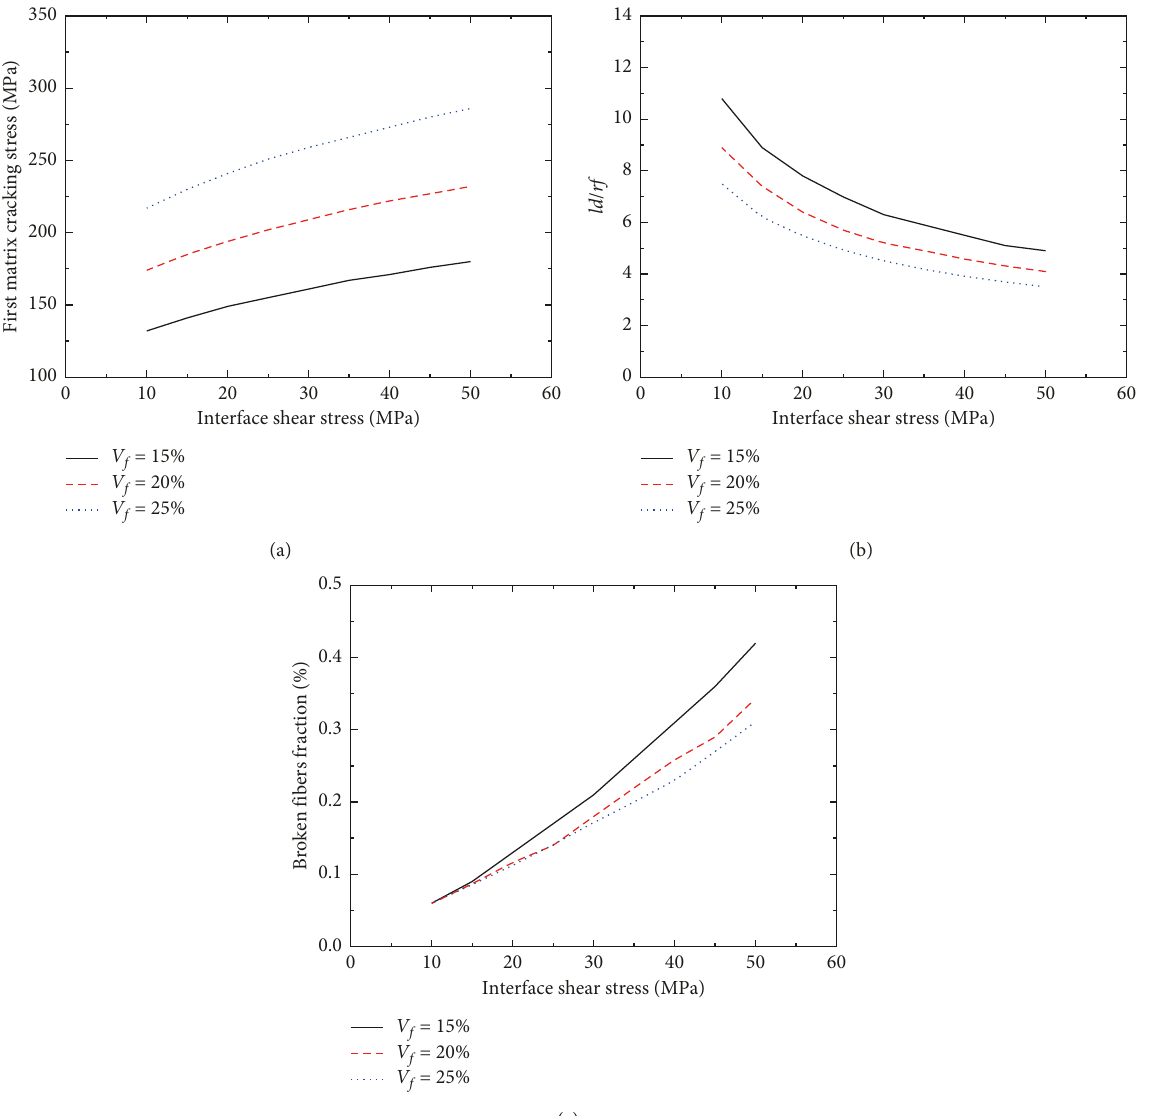
Figure 1: (a) The first matrix cracking stress versus the interface shear stress curves; (b) the interface debonding length versus the interface shear stress curves; (c) the broken fibers fraction versus the interface shear stress curves for different fiber